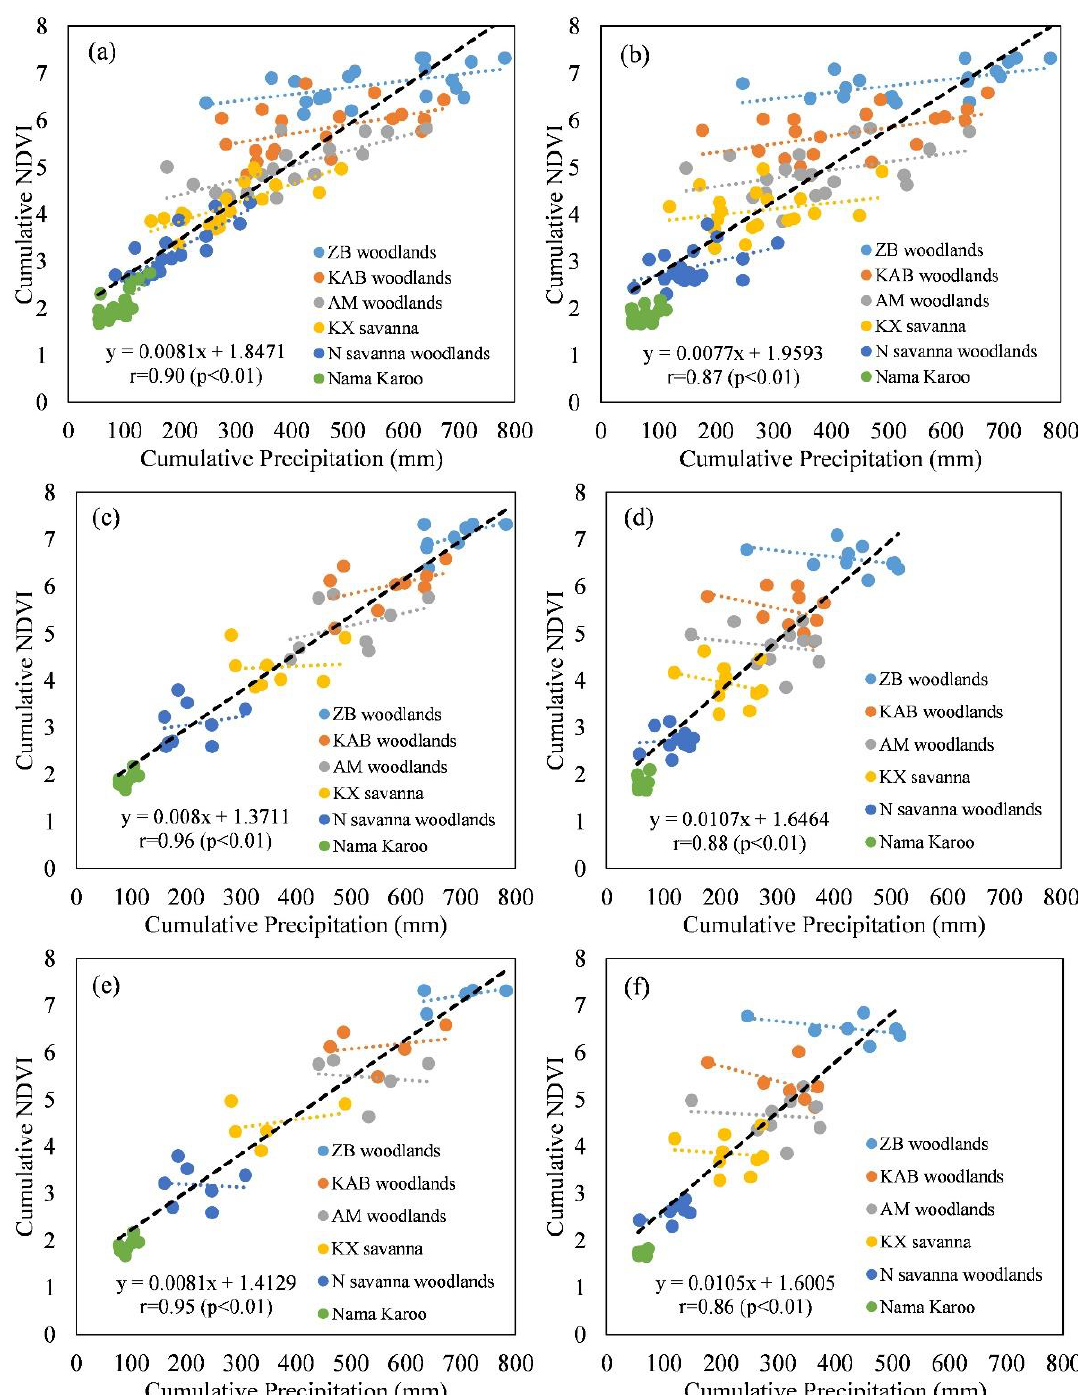
Figure 4. Scatterplot of seasonal cumulative precipitation and cumulative NDVI in Namibia over the past 20 years: ( a ) Cumulative precipitation in the current season vs. cumulative NDVI in the current season; ( b ) Cumulative precipitation in the current season vs. cumulative NDVI in the following season; ( c ) Cumulative precipitation in the current season vs. cumulative NDVI in the following season in wet years; ( d ) Cumulative precipitation in the current season vs. cumulative NDVI in the following season in dry years; ( e ) Cumulative precipitation in the current season vs. cumulative NDVI in the following season in consecutive wet years; ( f ) Cumulative precipitation in the current season vs. cumulative NDVI in the following season in consecutive dry years. The cumulative precipitation/NDVI in the current season represents the sum of precipitation/NDVI during the growing season.